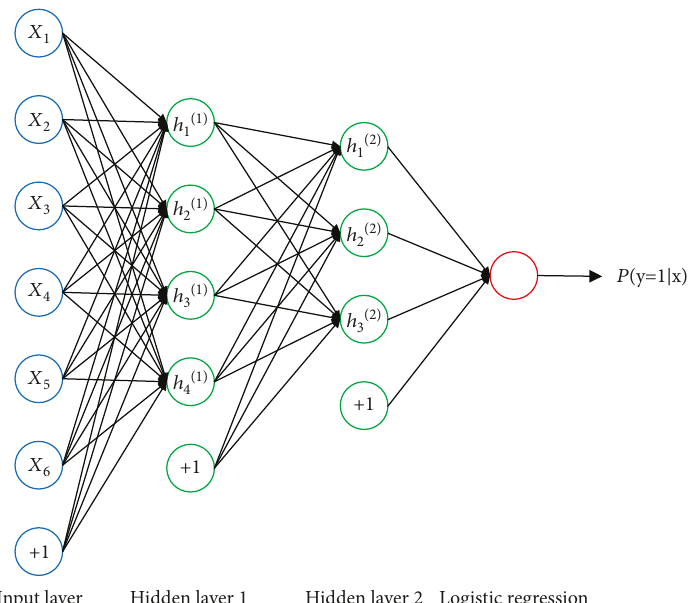
Figure 4: A two-layer stacked sparse autoencoder and logistic